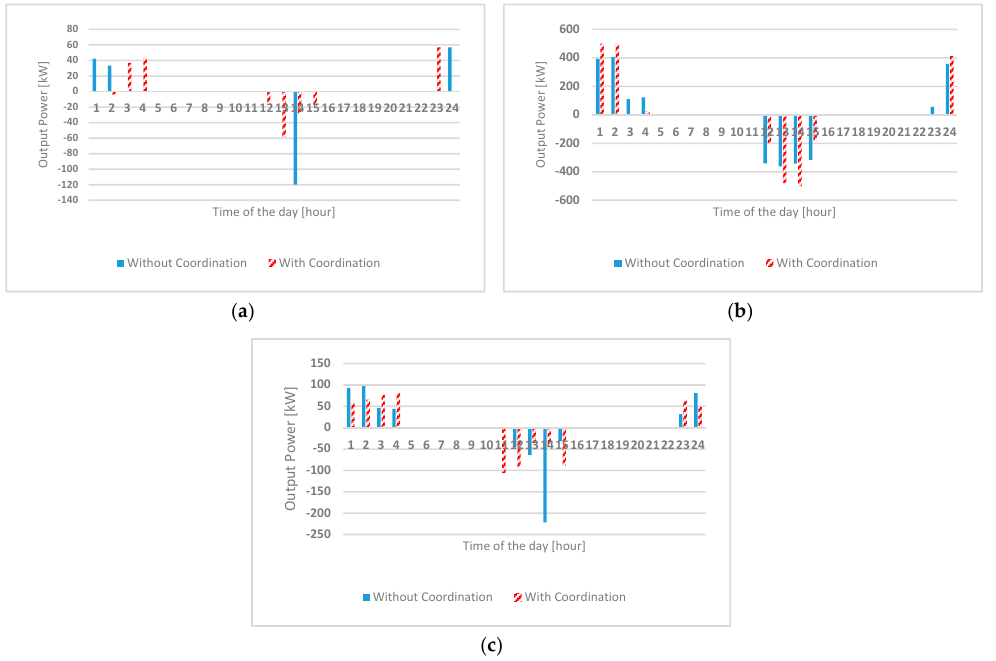
Figure 11. Battery output in each microgrid ( a ) MG1, ( b ) MG2, ( c ) MG3.